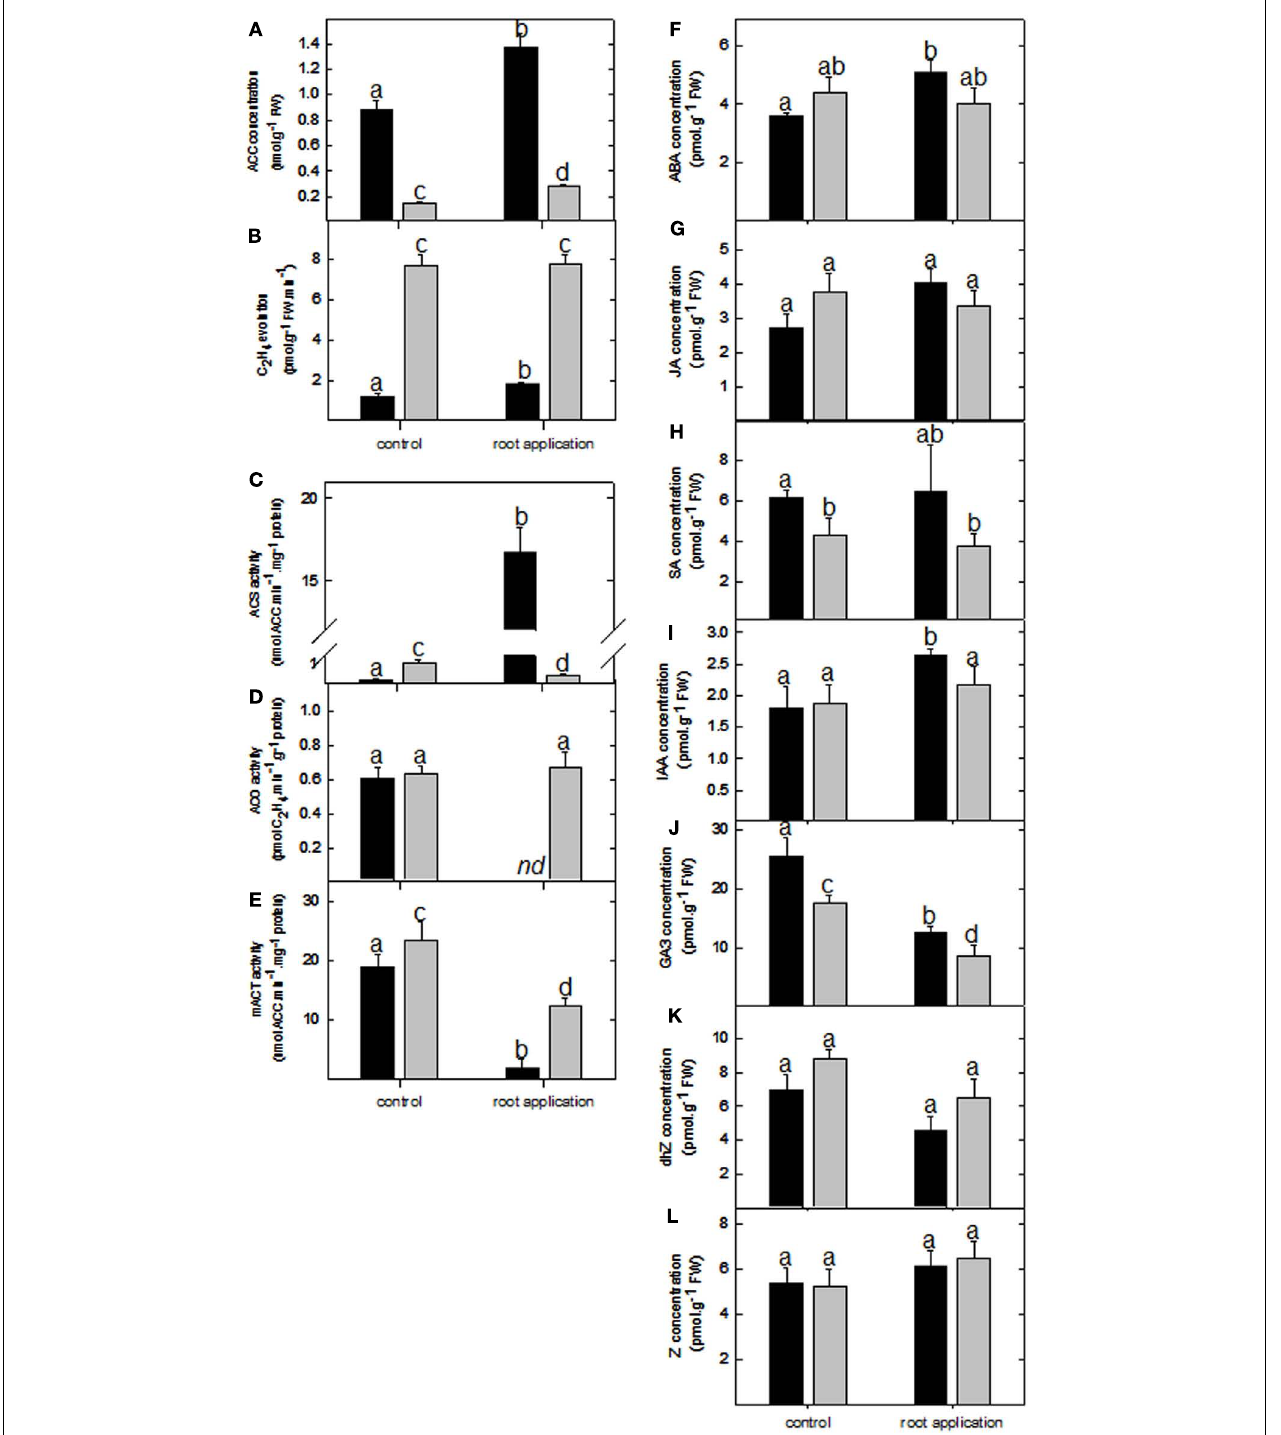
(F–L) Absolute levels of abscisic acid (ABA), jasmonic acid (JA), salicylic acid (SA), indole 3-acetic acid (IAA), gibberellic acid A3 (GA 3 ), dihydrozeatin (dhZ) and zeatin (Z).The values are the mean ± SE ( n = 6).The data was analyzed using one way ANOVA followed by Fisher’s least significant difference, bars that do not share letters are significantly different ( P < 0.05) from each other. nd, not